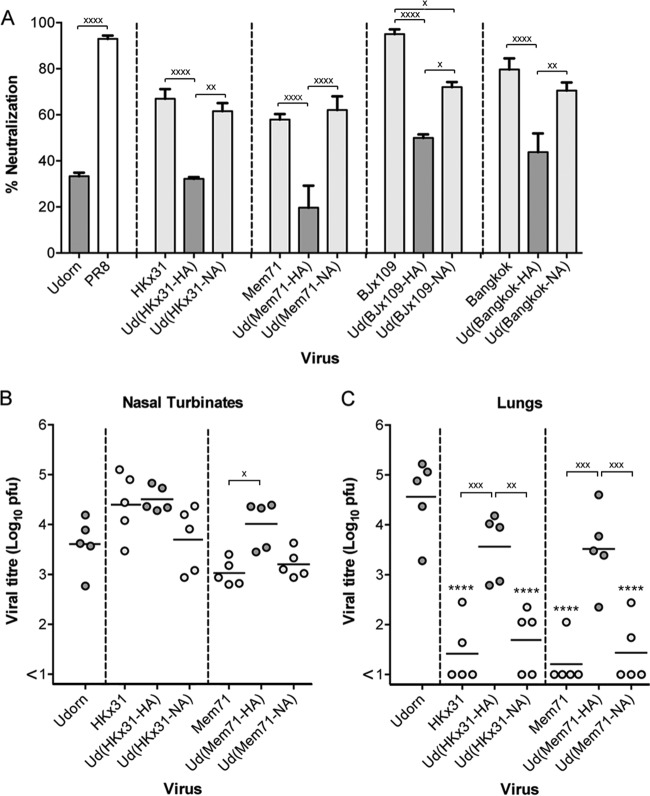
In vitro neutralization and in vivo progression of H3N2 hybrid viruses. Viruses (5,000 PFU) were mixed with untreated saliva or RPMI plus BSA as a control at a 9:1 (vol/vol) ratio of virus to saliva. The mixtures were then incubated at 37°C for 30 min before being added to MDCK cell monolayers, and viral infectivity was determined by plaque formation. The percent neutralization of each viral strain by saliva is shown (A). The viral origin of the NA is denoted by differently shaded bars: Udorn, dark gray; donor H3N2, light gray; and PR8, white. The data represent means and standard deviations of the results of at least 2 individual experiments, each performed in triplicate. BALB/c mice were infected via the URT with 104.5 PFU of the indicated hybrid viruses. After 6 days, nasal turbinates (B) and lungs (C) were removed, and viral titers in homogenates were determined by plaque assay on MDCK cell monolayers. Individual titers (circles) and the mean viral titers of 5 mice per group (horizontal lines) are shown, expressed as titers per organ. Dark-gray circles, viruses containing Udorn NA; light-gray circles, viruses containing a donor H3N2 NA. For the indicated comparisons: x, P < 0.05; xx, P < 0.01; xxx, P < 0.001; xxxx, P < 0.0001. Additionally, in panel A, all dark-grey bars are significantly different from PR8 (P < 0.0001). In panel C, ****, P < 0.0001 compared to Udorn.